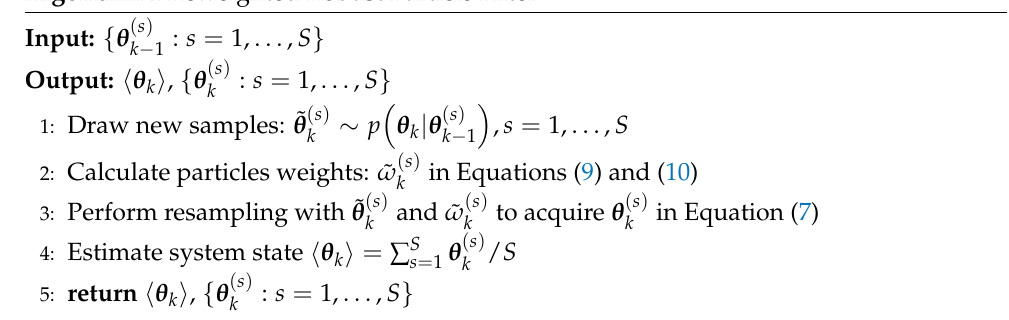
Algorithm 1 Reweighted Robust Particle Filter